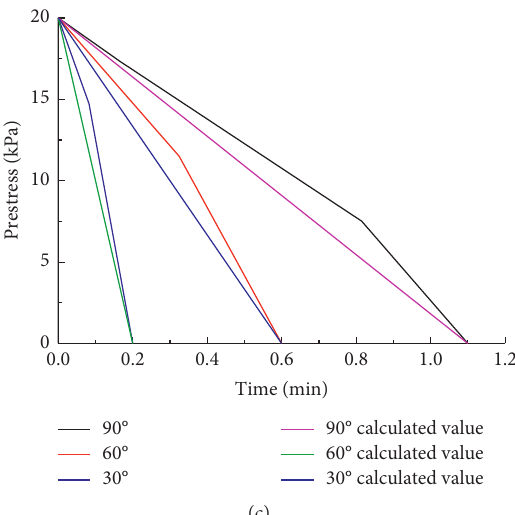
Figure 11: Comparison of stress level prestress loss curves. (a) The stress is 2 MPa. (b) The stress is 4MPa. (c) The stress is